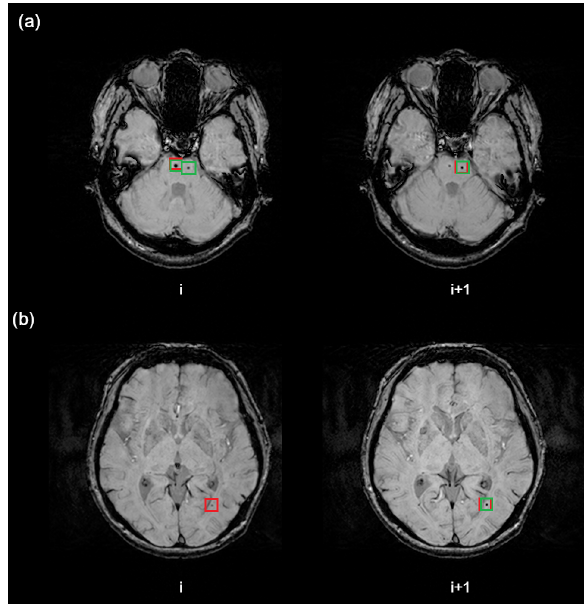
Figure 5. Two example cases presenting the application of predictions post-processing stage. The ( a ) example represents verification of false-positive prediction and ( b ) example represents verification of ground truth CMB detection